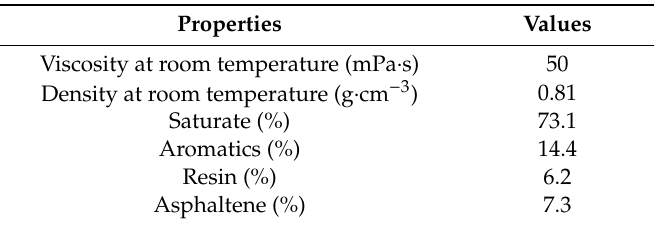
Table 1. Properties of the crude